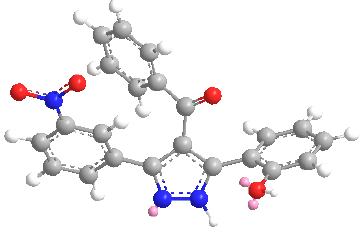
Figure 1. Energy minimized form of [5-(2hydroxyphenyl)-3-(3-nitrophenyl)-(4-benzoyl)]- pyrazol and its deprotonated species.